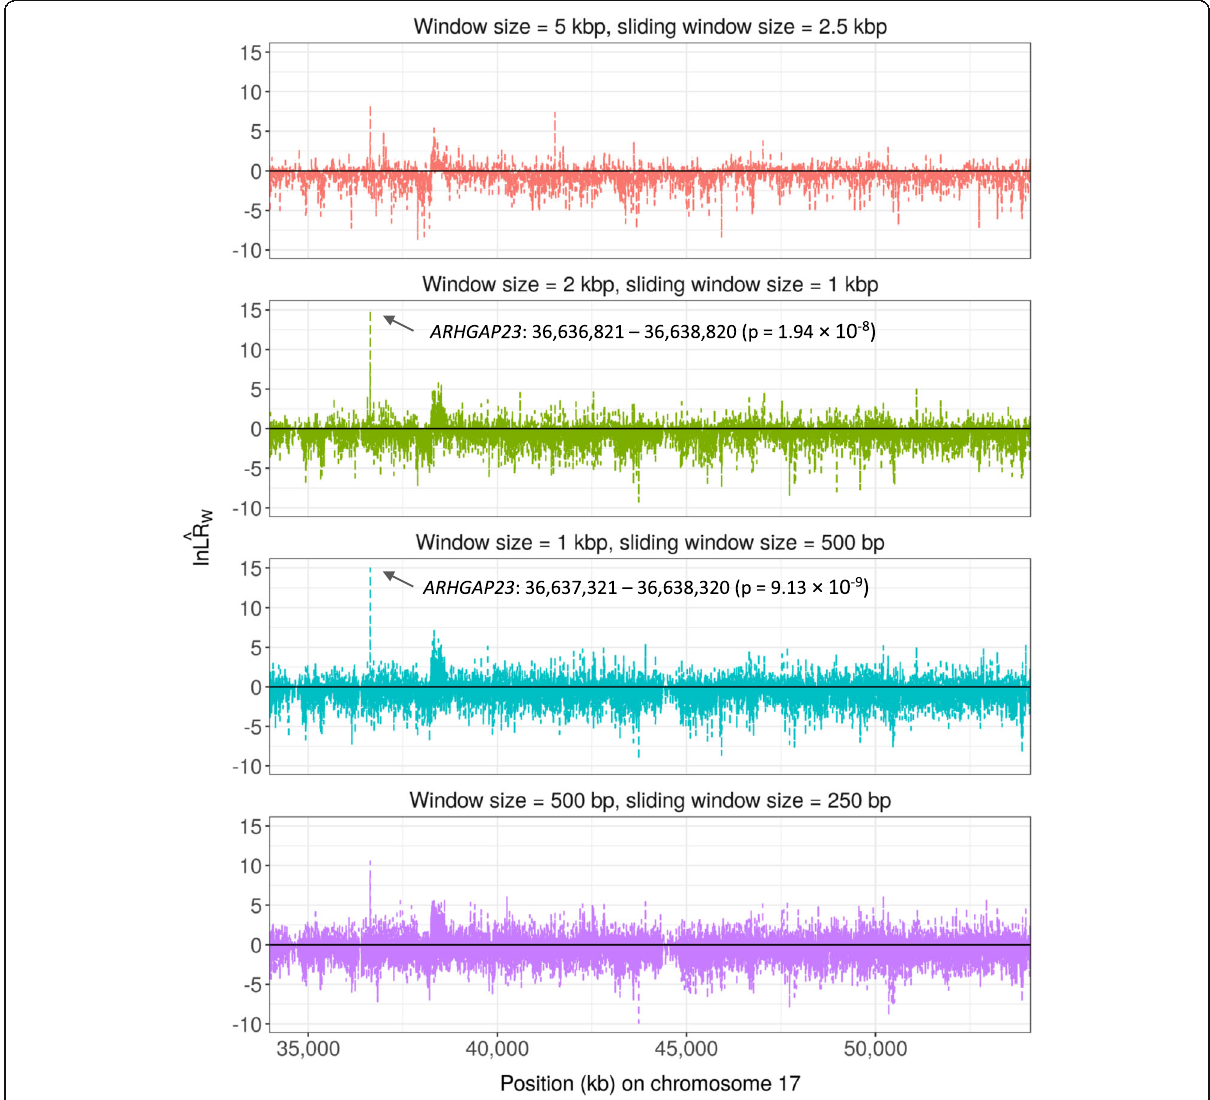
Fig. 4 Plots of ln b LR W for the associations between rare variants around MAPT (± 10 M bp) located on chromosome 17 and log-transformed CSF phosphorylated tau levels in ADNI. Positive ln b LR W represents test statistics for ^ μ W